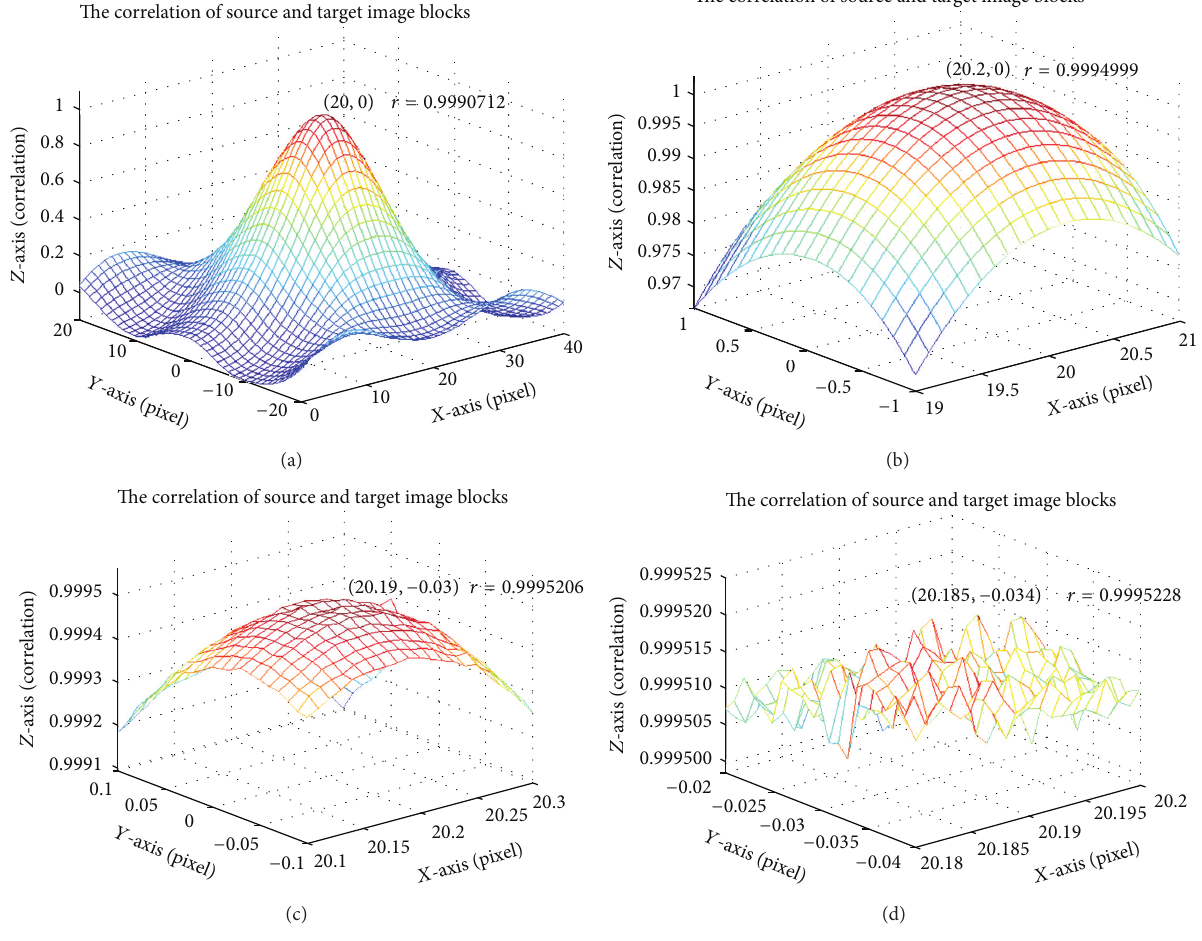
Figure 7: Variation of correlation coefficient with displacement scales: (a) 1 pixel, (b) 0.1 pixel, (c) 0.01 pixel, and (d) 0.001